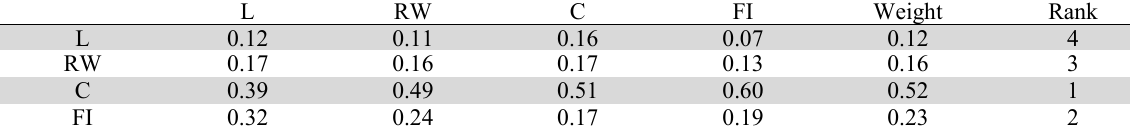
Normalized Matrix and weight of criteria (Input)